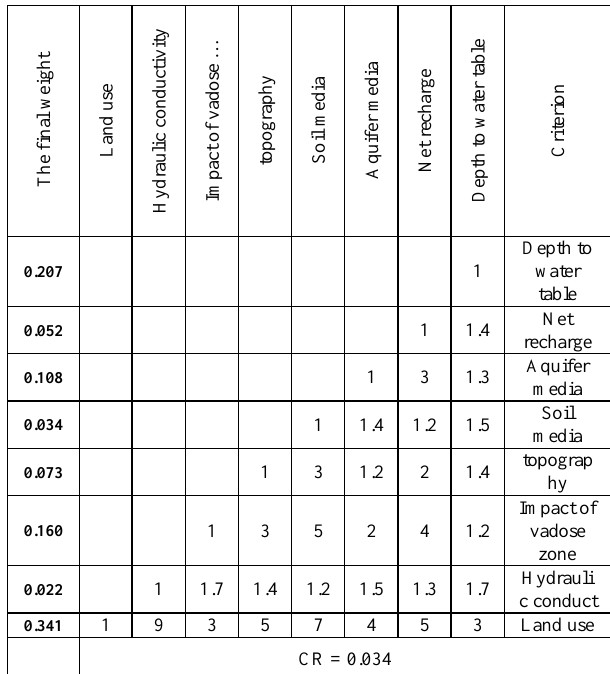
Figure 2: The map of Ajabshir vulnerability potential extracted from modified-DRASTIC model Table 3: Paired comparisons of